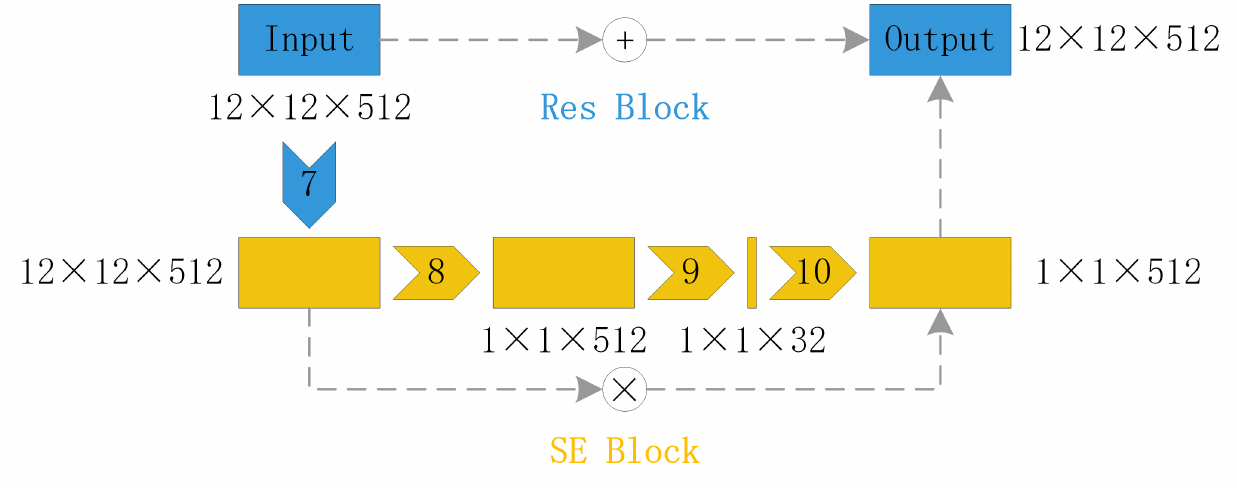
Figure 7. Architectures of Res-SE-U-Nets in flow field construction.